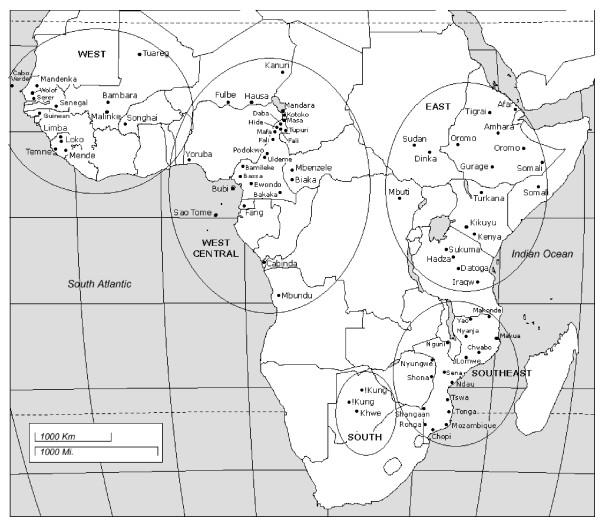
Map depicting the geographic locations and the regional groupings of the population samples used in this study.